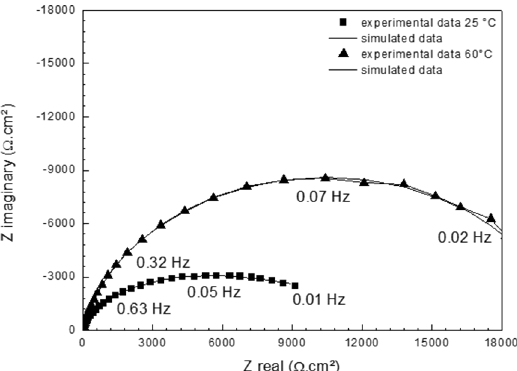
Figure 7. Nyquist diagram of uncoated Ti–6Al–4V alloy in 2 M NaOH at 25 and 60 °C.